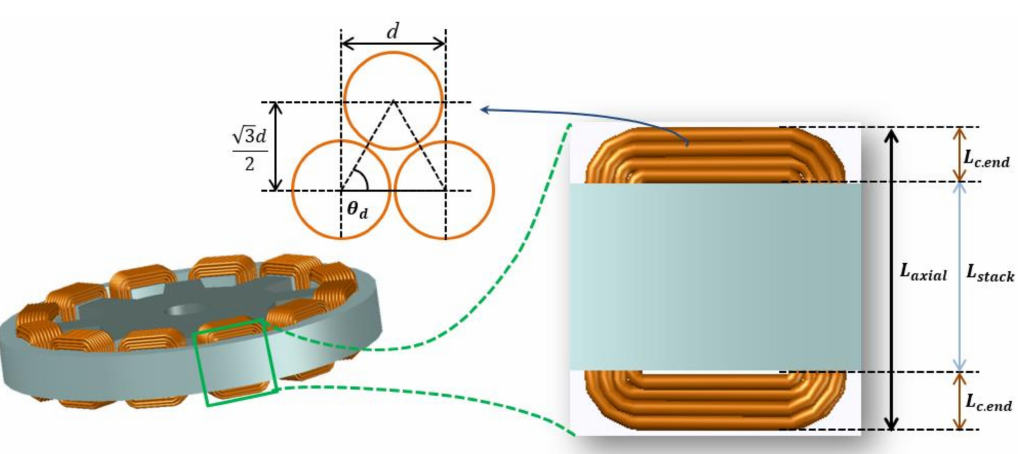
Figure 2. End coil calculation of stator